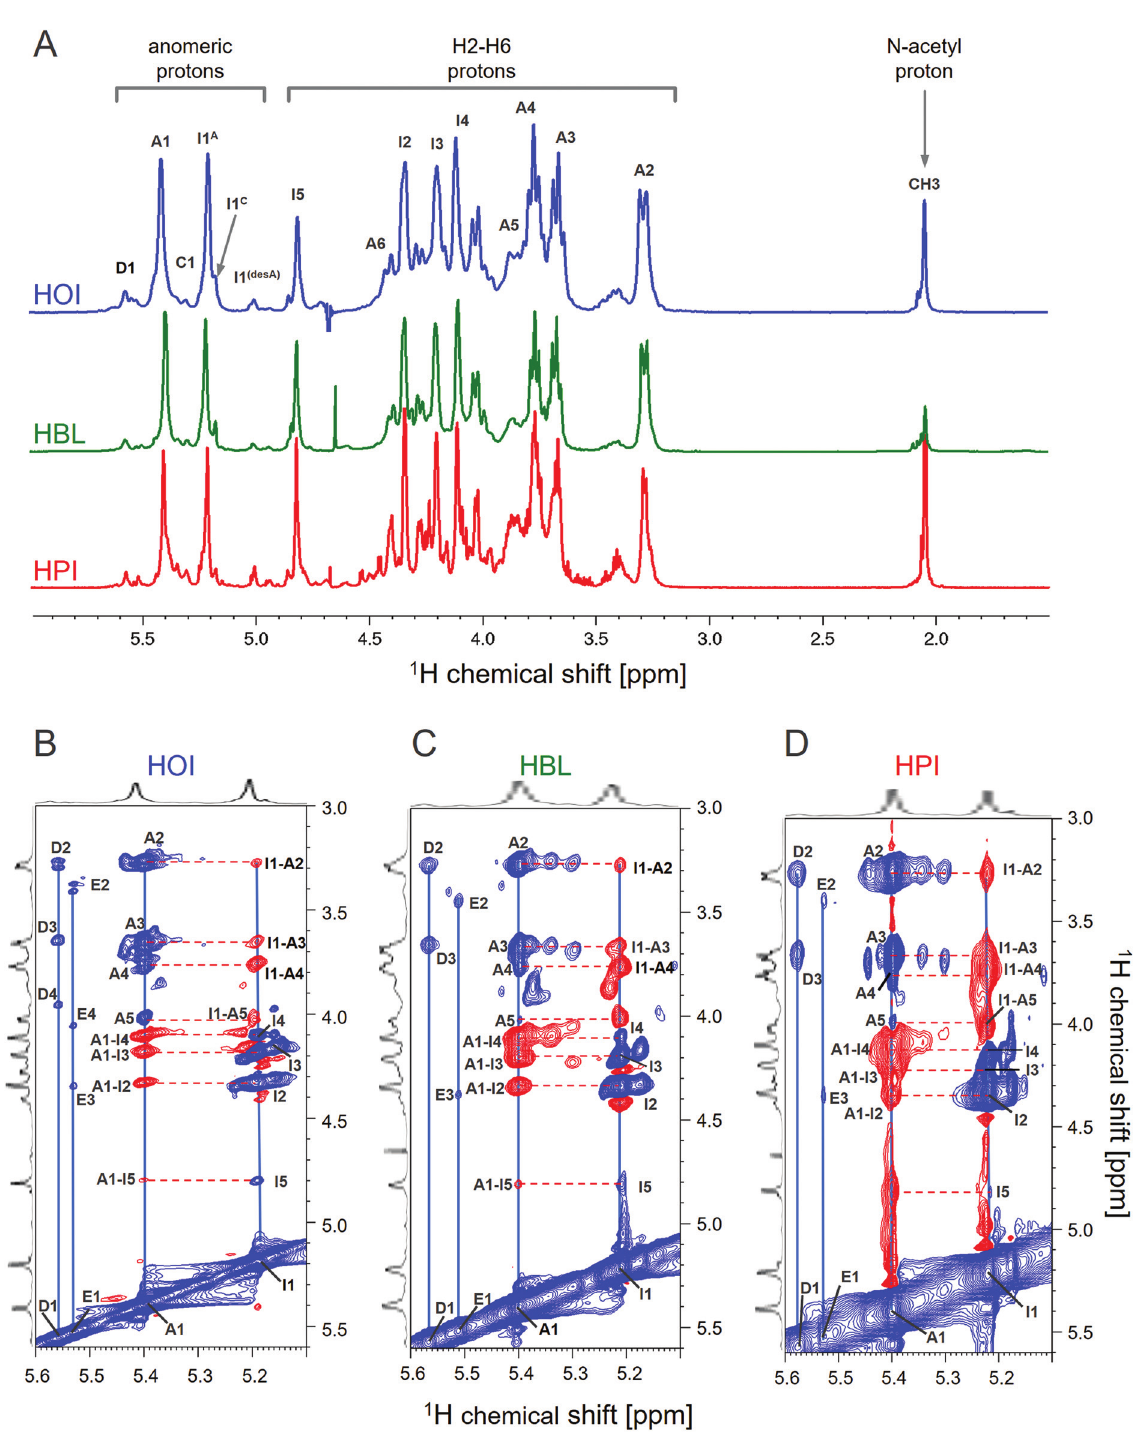
Fig. 3 1 H NMR spectra reveal structural similarity among heparins from different sources. (A) 1D 1 H spectra (6.0 – 1.0ppm) of HOI (blue), HBL (green) and HPI (red). Annotations in the panel indicate signals of the anomeric protons of α -Glc N ,6-diS (A1), α -Glc N S (C1); H1 (I1) and H5 (I5) of α -IdoA2S; and CH N -acetyl group from α -Glc N . (B – D) Phase-sensitive 1 H- 1 H TOCSY spectra of HOI, HBL and HPI differentiates signals of 3 of the intra-residue spin systems (in blue) from those of inter-residue ROEs (in red). The anti-phase and in-phase connections are indicated by the horizontal red dotted and the blue vertical lines, respectively. The most intense anti-phase signals show the linkage to the subsequent sugar residue. Spin systems D and E correspond to β -GlcA linked to α -Glc N ,6di-S or α -Glc N ,3,6tri-S, respectively.